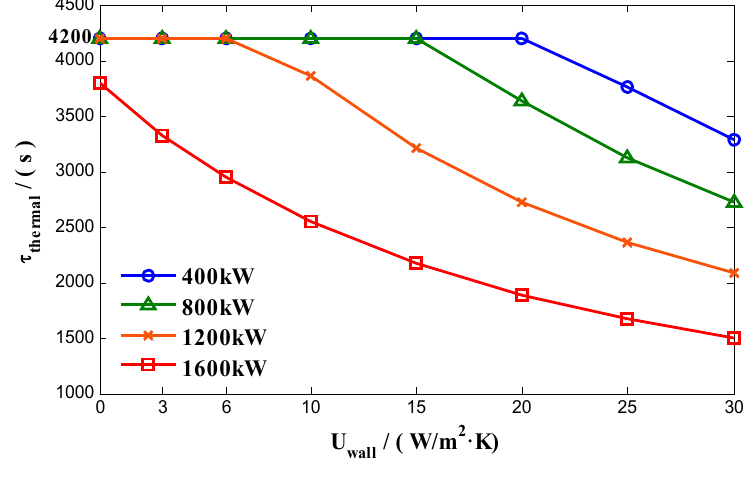
Figure 7. Influence of U wall on τ thermal .